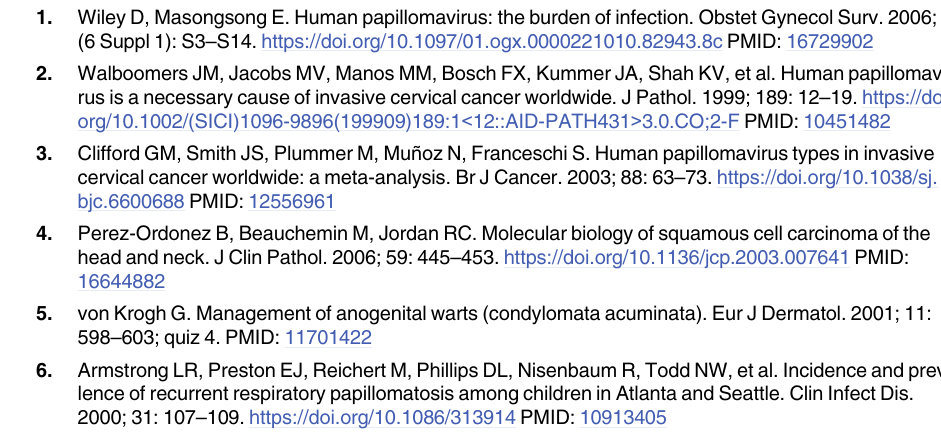
S1 Fig. Information flow through the different phases in the systematic literature review.